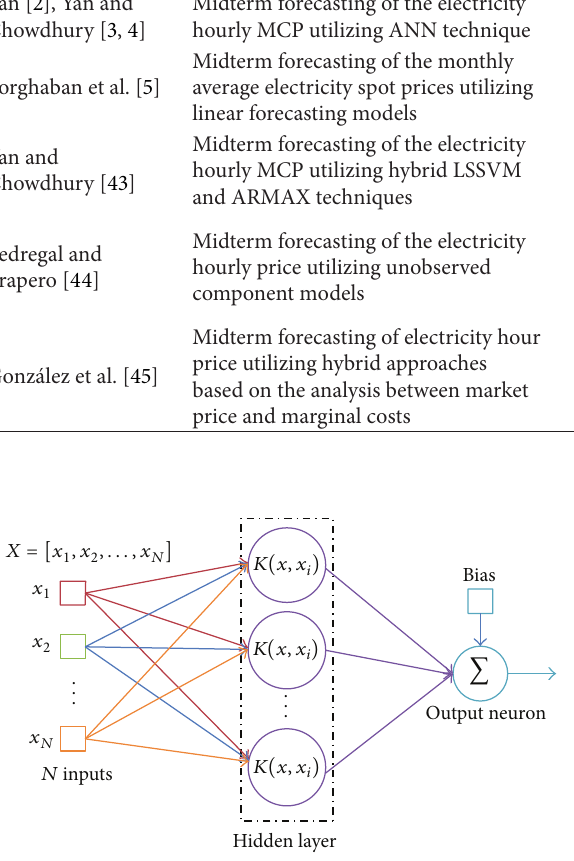
Figure 1: SVM architecture